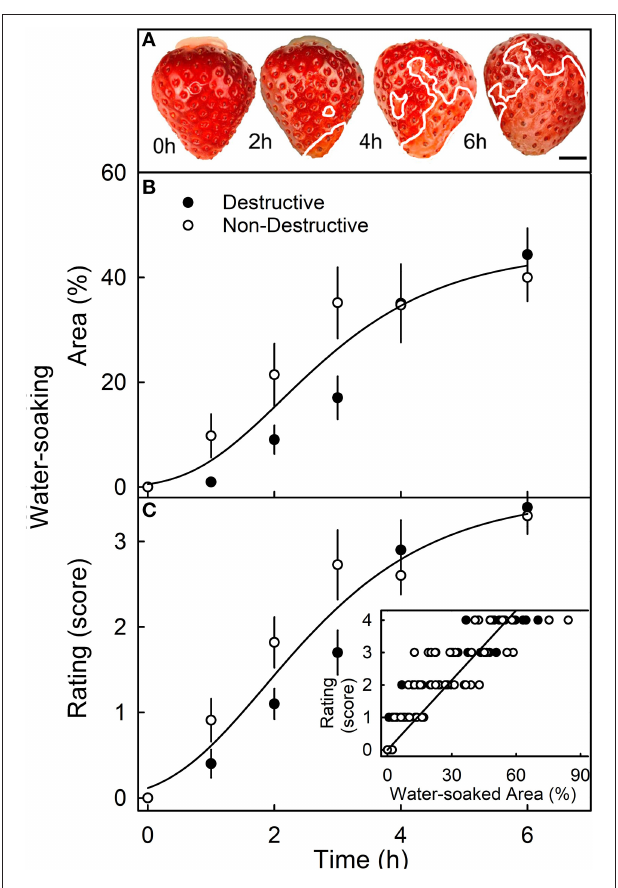
FIGURE 3 | Time course of water soaking. (A) Macroscopic view of change in water-soaked area with time. The symptomatic area is indicated by a solid white line. Scale bar, 5mm. (B,C) Change in water soaking as indexed by the measurement of the water-soaked area (B) or as assessed by a 5-point rating scale (C) . ( C , inset): Relationship between the water-soaked score and the water-soaked area. For the destructive sampling depicted in (B) , an independent set of fruit was assessed at any one time. For the non-destructive sampling in (B) , repeated observations were made on the same fruit that was photographed repeatedly. The water-soaked area was quantified by digital analysis. The 5-point rating scale: score 0, no water soaking; score 1, < 10% of the surface area water-soaked; score 2, 10–35%; score 3, 35–60%; score 4 > 60%.